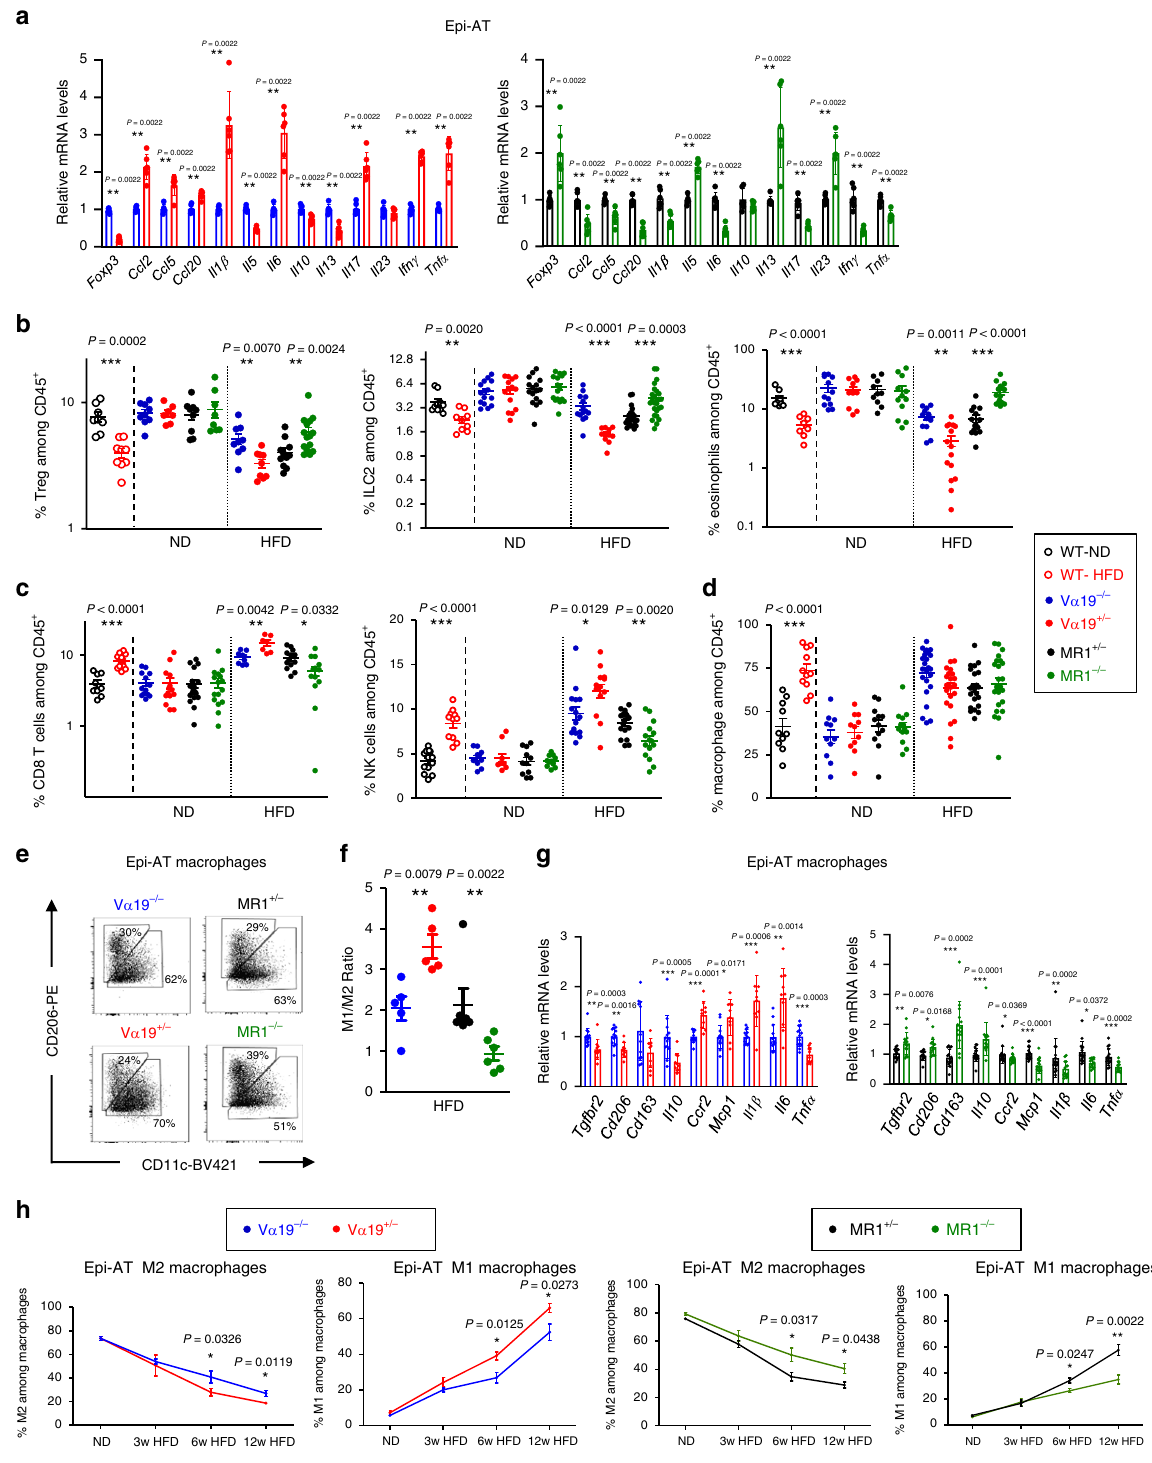
decrease of Actinobacteria phylum when compared with their littermate controls, whereas other phyla (Bacteroidetes, Firmi- cutes, Protobacteria, and Deferribacteres) remained unchanged (Fig. 6i; Supplementary Fig. 13b). In agreement, Coribacteriaceae family (Actinobacteria phylum) and Olsenella genus (a member of Coribacteriaceae family) decreased in MR1 − / − mice when compared with their littermates (Fig. 6j; Supplementary Fig. 13c). Conversely, an increase of Clostridiaceae (belonging to Firmicutes phylum) existed in MR1 − / − mice compared with their control